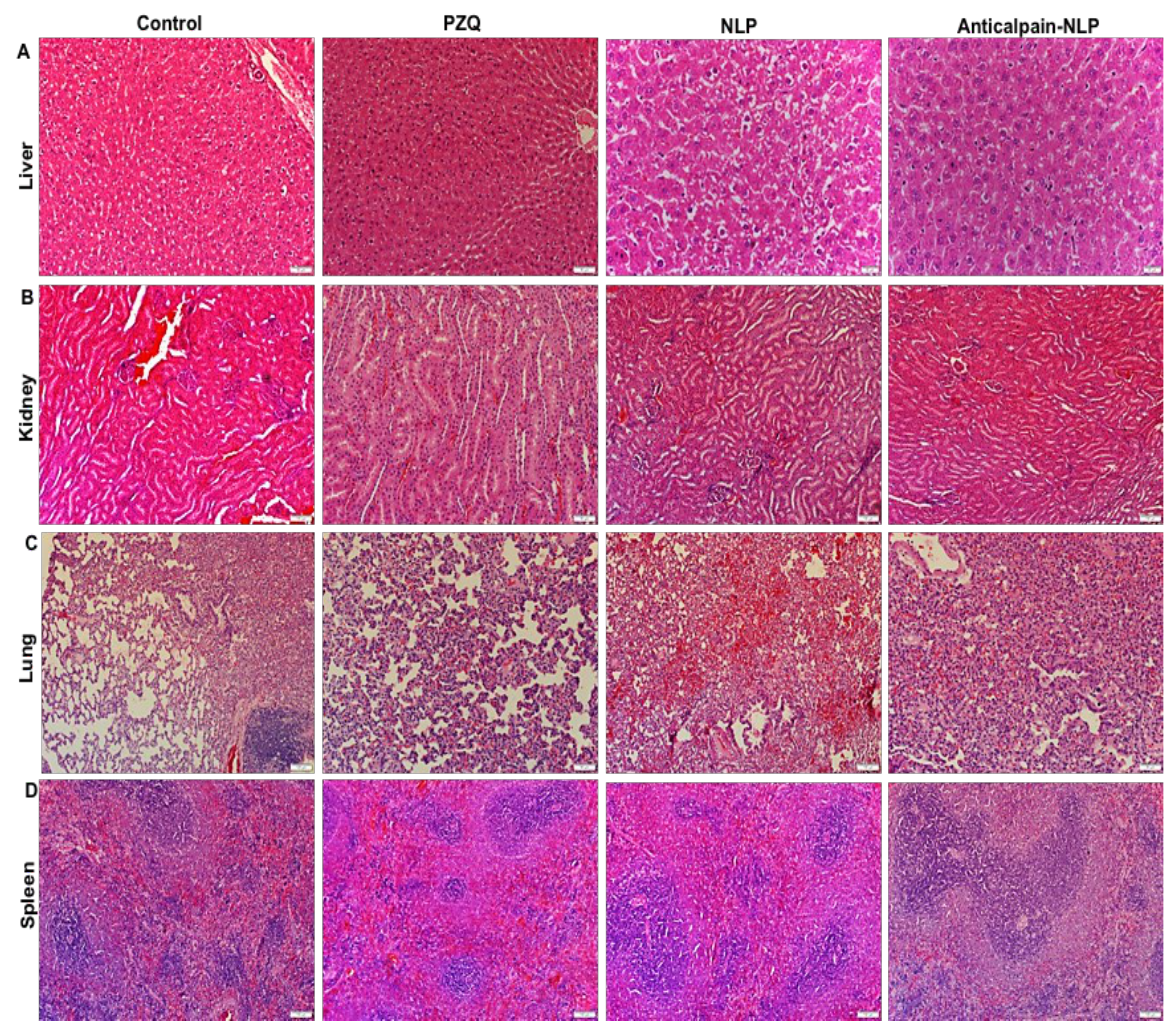
Figure 11. Histopathological sections of ( A ) liver, ( B ) kidney, ( C ) Lung, and ( D ) spleen after treating uninfected rats with 250 mg/kg of PZQ, NLP, and anti-calpain-NLP. Hematoxylin and eosin staining (×20 magnification).